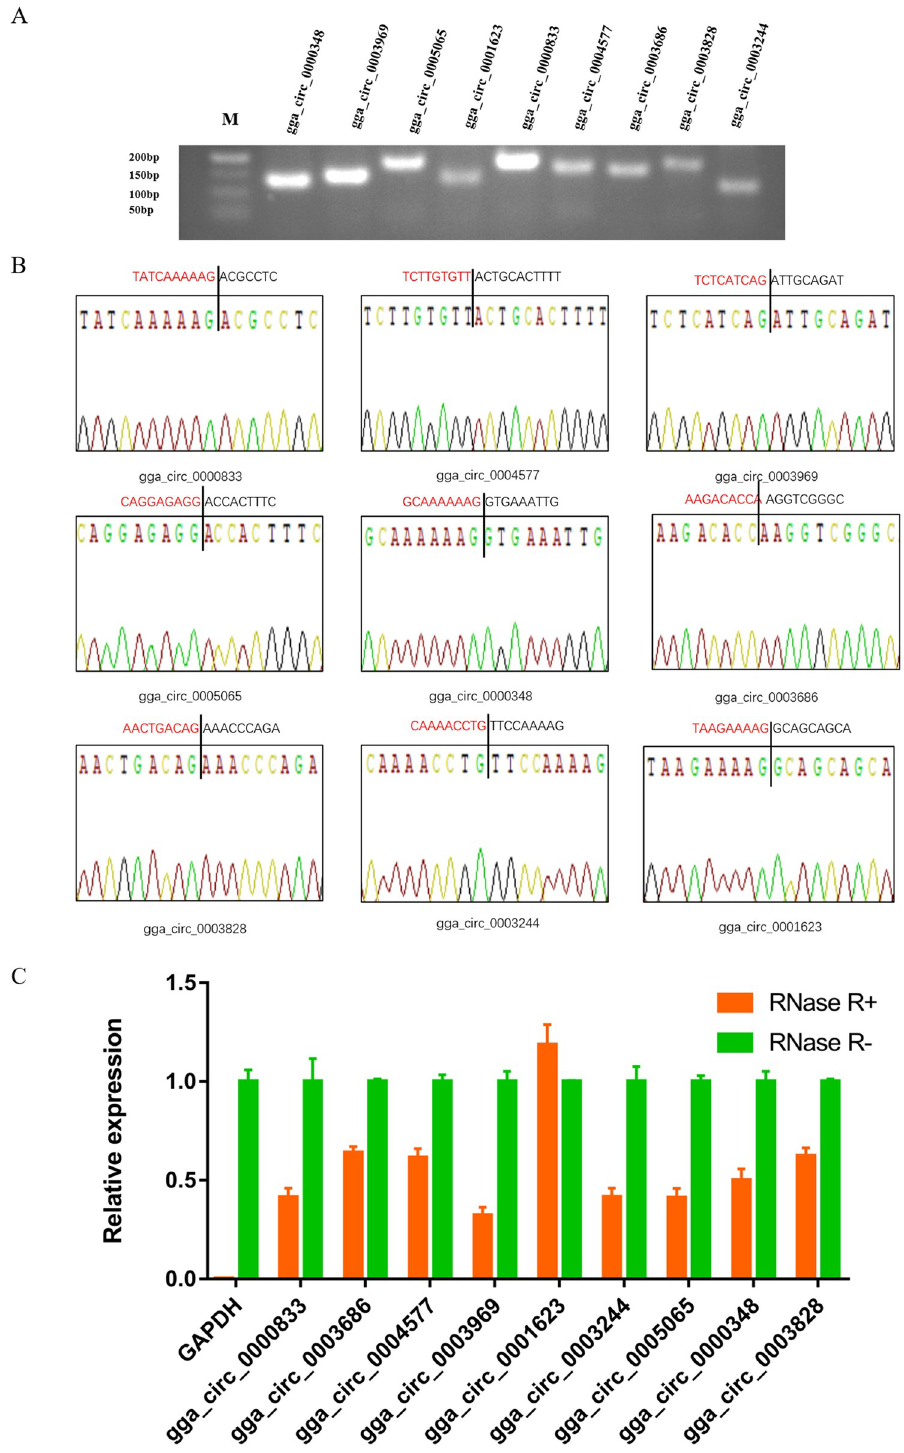
Fig 1. Verification of 9 randomly selected circRNAs. (A) Electrophoretogram of the PCR products. M: marker 500. (B) The head-to-tail junctions of 9 circRNAs were confirmed by Sanger sequencing. The black line indicates the position of reverse splicing. The area marked with red (or black) is the end (or start) sequence of the circRNAs (junction). (C) qRT-PCR was used to detect the resistance of circRNA to RNase R digestion. GAPDH was used as a linearity control. Data are expressed as means ± SEM (n =